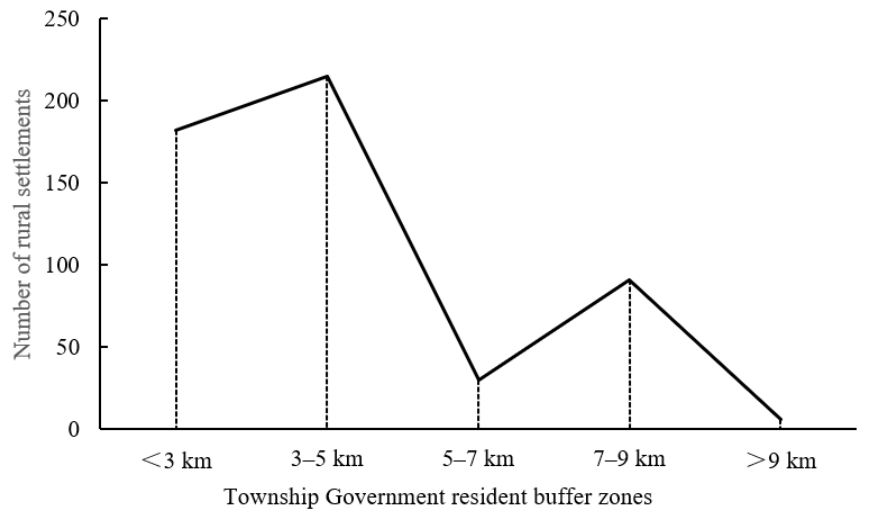
Figure 6. Distribution of rural settlements in the study area based on location environmental factors. (a) Number of rural settlements on different road buffer zones; (b) Number of rural residential areas in different township government resident.